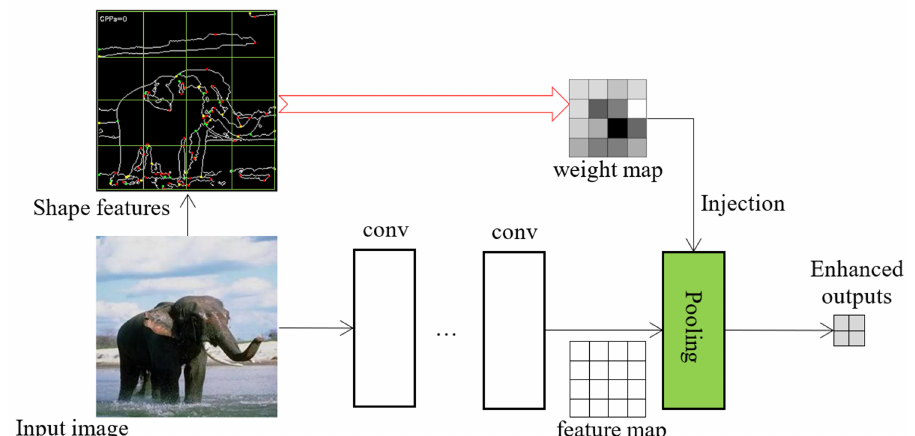
Figure 3. An example of feature weight map injection. The feature map from the convolutional layers is jointly processed with the injected weight map in the proposed pooling layer. The preprocessed handcrafted features are saved as files and are loaded into the network during